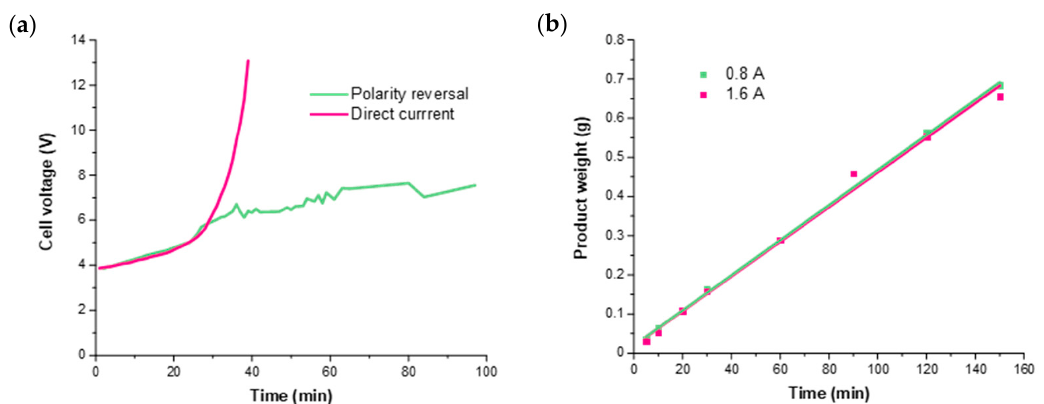
Figure 2. ( a ) The cell voltage of the electrosynthesis system with and without 0.250 Hz polarity reversal frequency with 0.8 A current, and ( b ) the product in the solution when synthesis was done using 0.8 A and 1.6 A currents with 0.250 Hz polarity reversal frequency. The syntheses were done at ambient temperature in 0.078 M BTC solution.